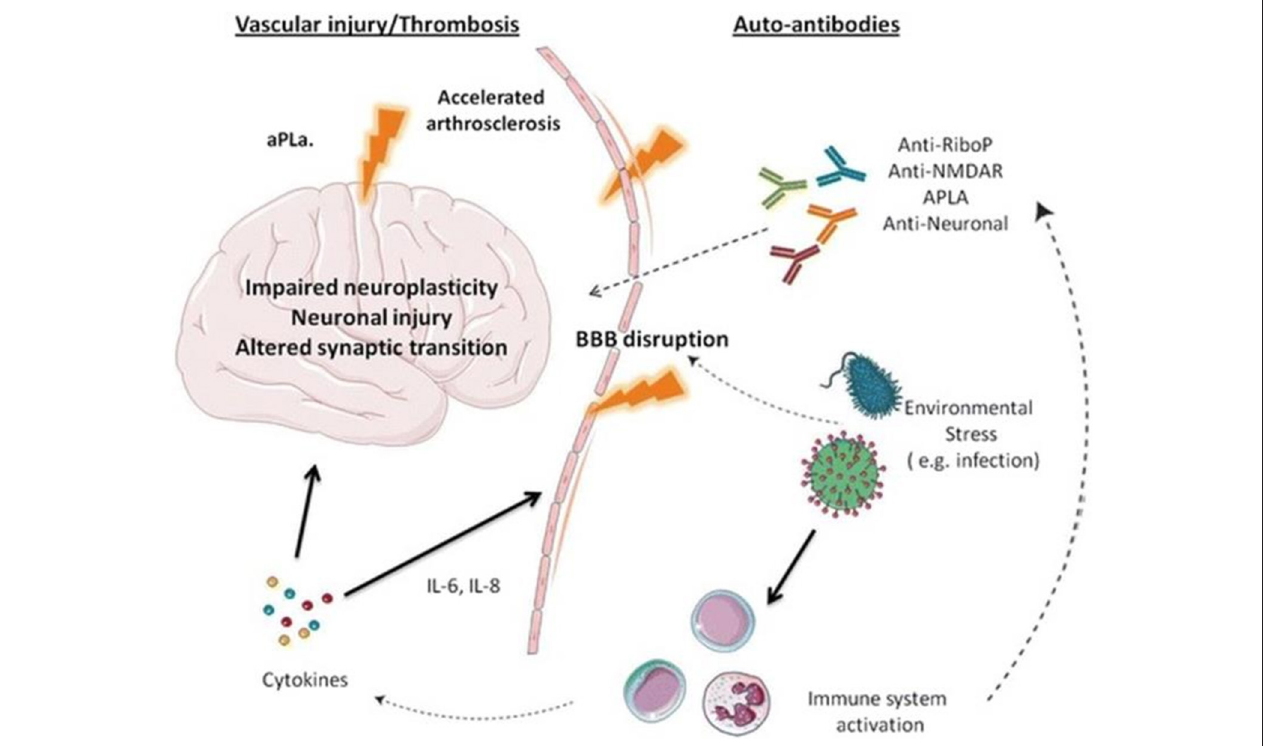
FIGURE 1 | Pathogenesis of